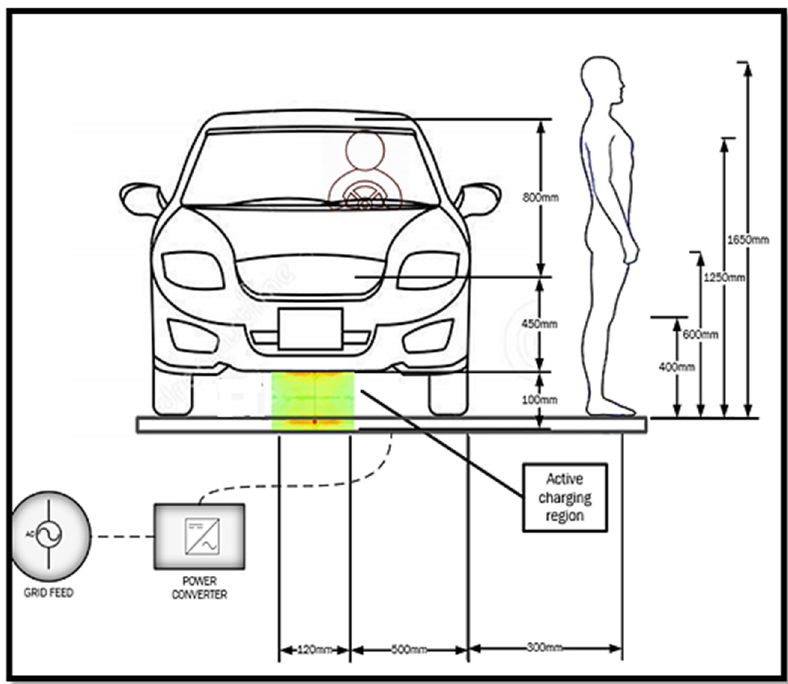
Figure 11. Human and animal positioning samples for the electromagnetic study.